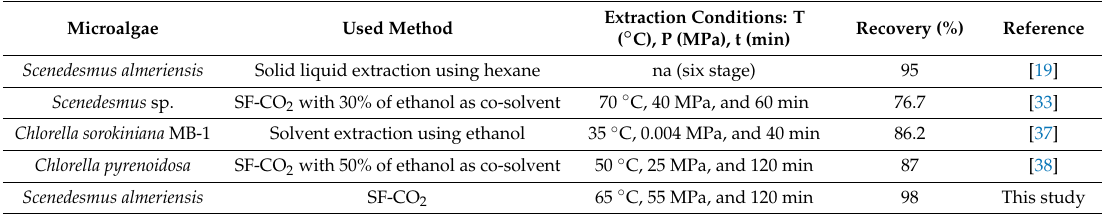
Table 4. Comparison of the performance of SF-CO 2 method used in this study with the performance obtained from other methods using green solvent for lutein extraction from several microalgae.